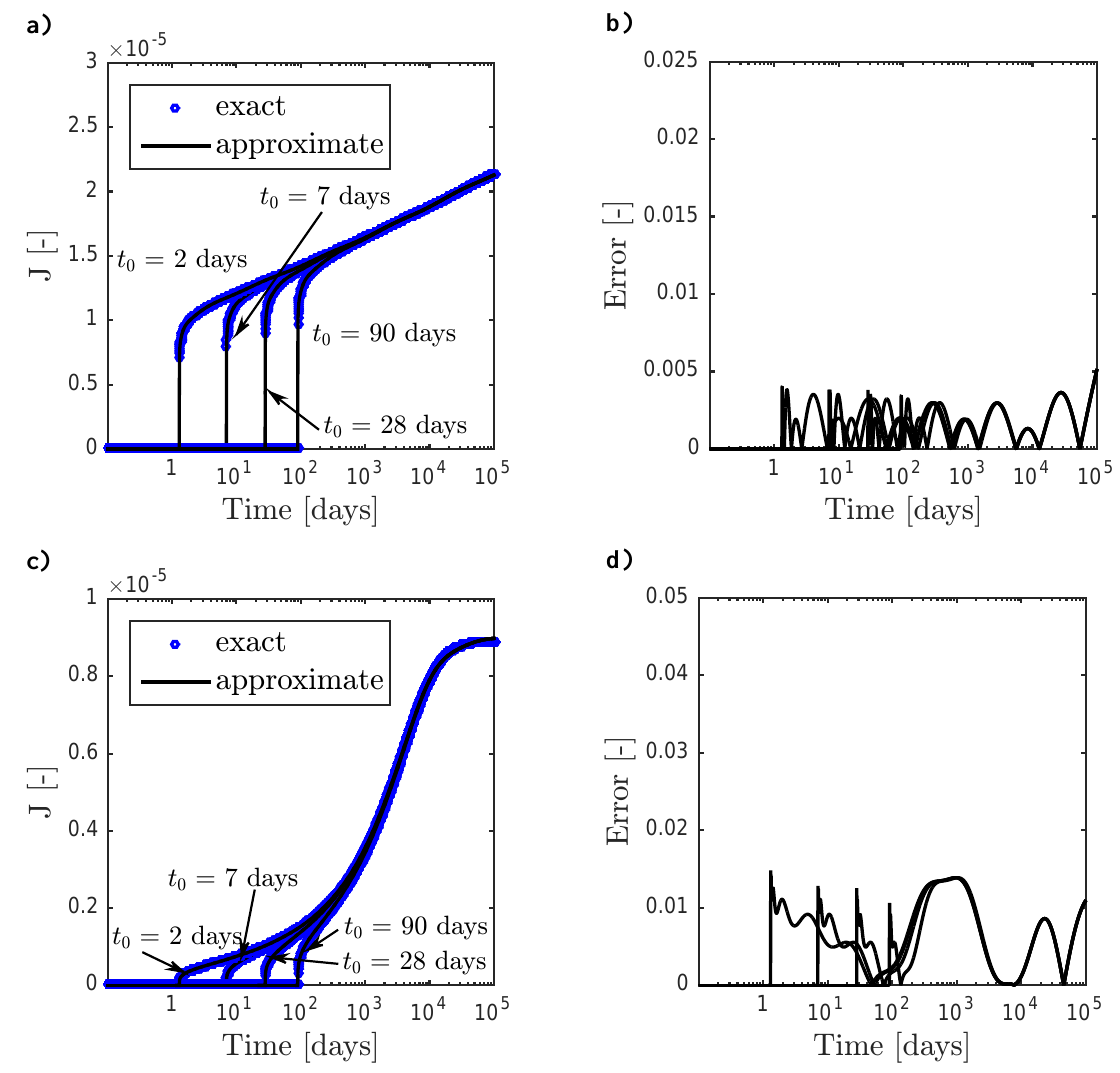
Figure 3. Approximation of the B3 model compliance functions for different t 0 (2, 7, 28, and 90 days): Basic creep function ( a ) and absolute value of the approximating error ( b ); drying creep function ( c ) and absolute value of the approximating error ( d